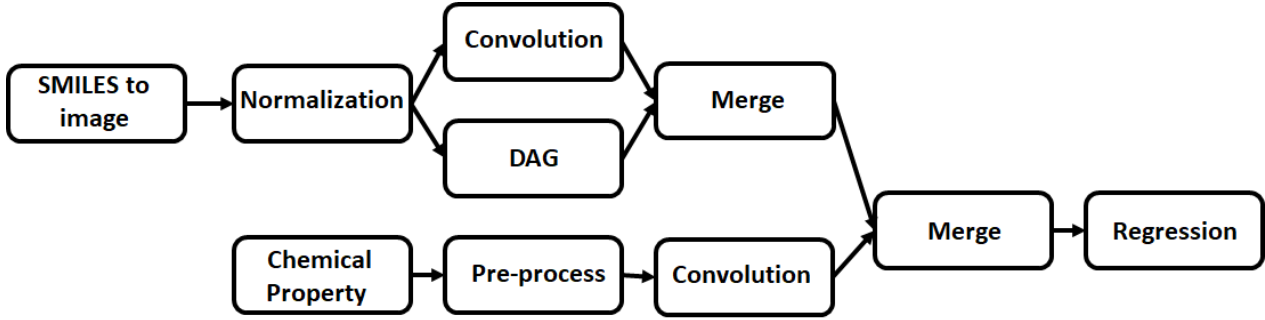
Figure 3. The concept behind the multitask regressor algorithm, simultaneously predicting values based off different chemical properties and then merging these values to generate an overall numerical prediction.